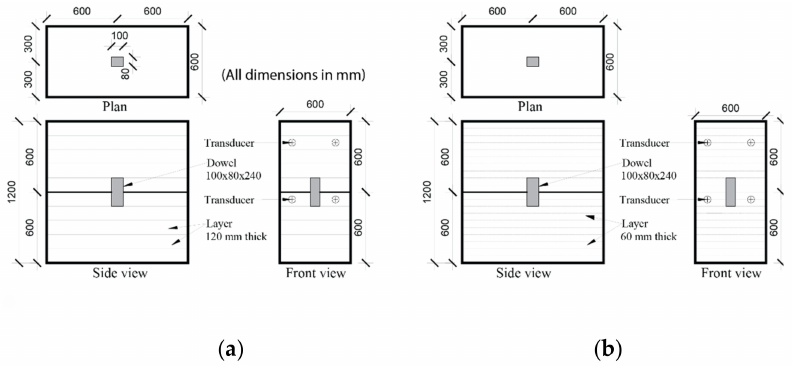
Figure 2. Test specimen details and measuring points: ( a ) Reinforced RE with 120mm layer thickness (TEST–R120); ( b ) Reinforced RE with 60mm layer thickness